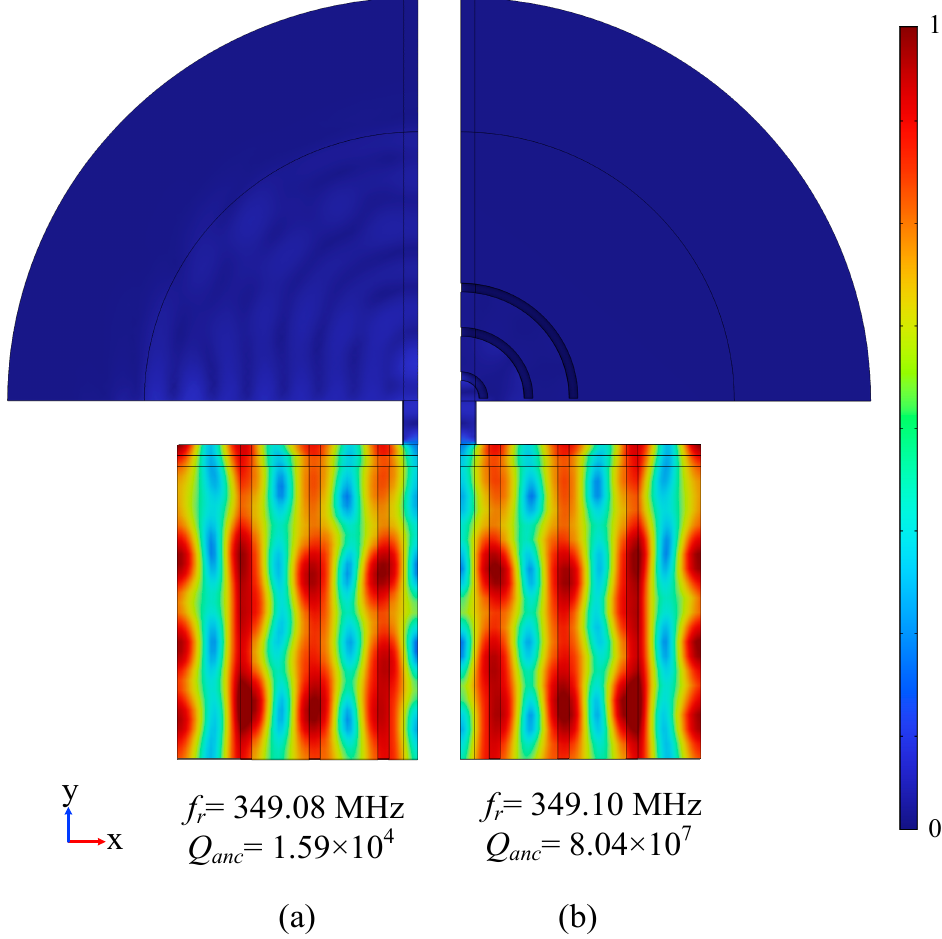
Figure 7. Finite element simulation of resonance mode. ( a ) Conventional LWR mode 1/4; ( b ) LWR mode 1/4 with three cycles of H-RPC and R = 0. f r is the resonant frequency and Q anc is the quality factor of the anchor.